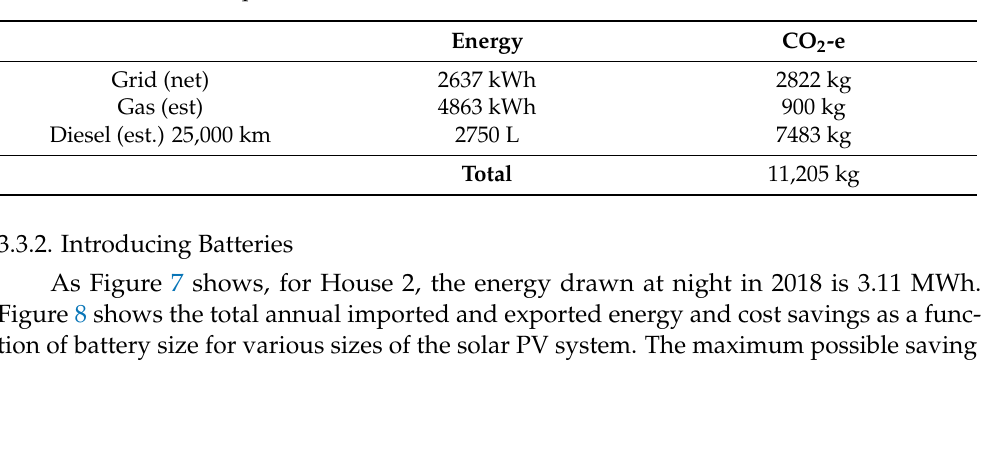
Table 4. House 2: CO 2 equivalent emissions